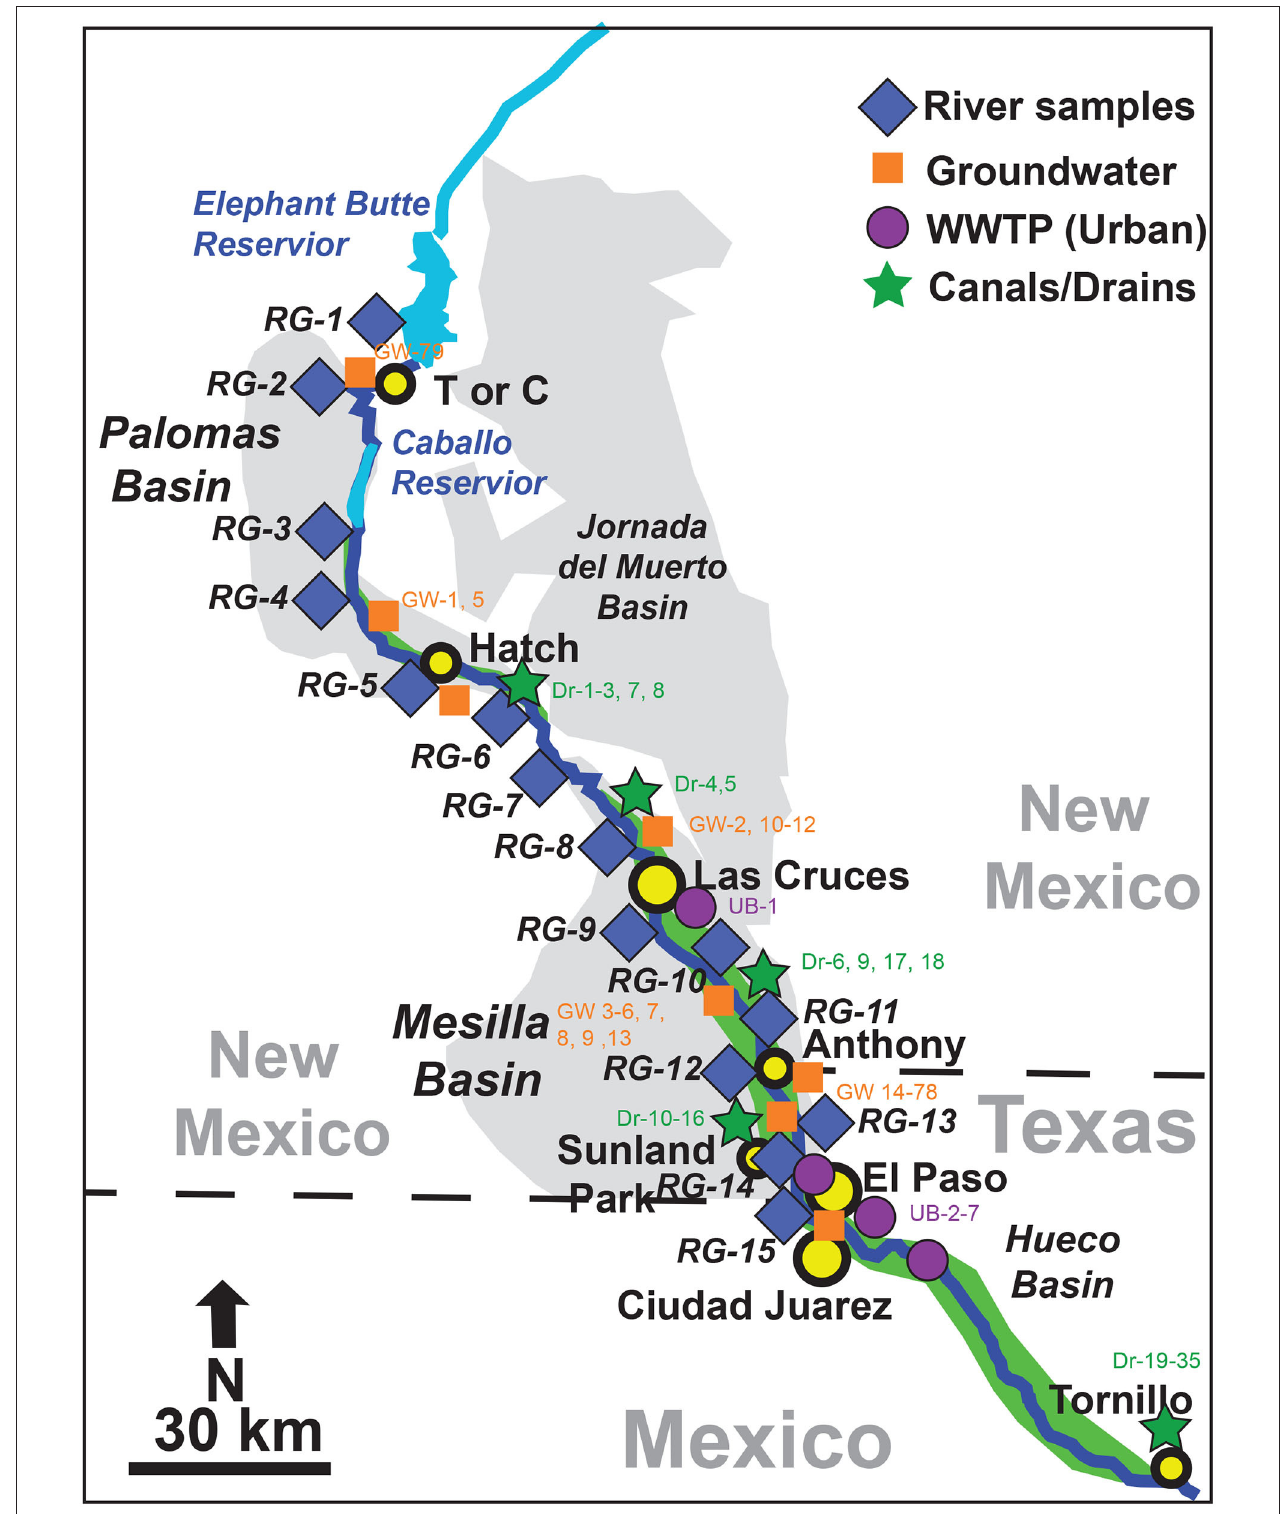
FIGURE 2 | The ∼ 200km stretch of the Rio Grande from Elephant Butte reservoir in NM to El Paso, TX. Sample locations for river water, groundwater wells, agricultural canals and drains, and urban water (wastewater treatment plants: WWTP) are indicated. Details of sample location information is in Appendix Table 1 .